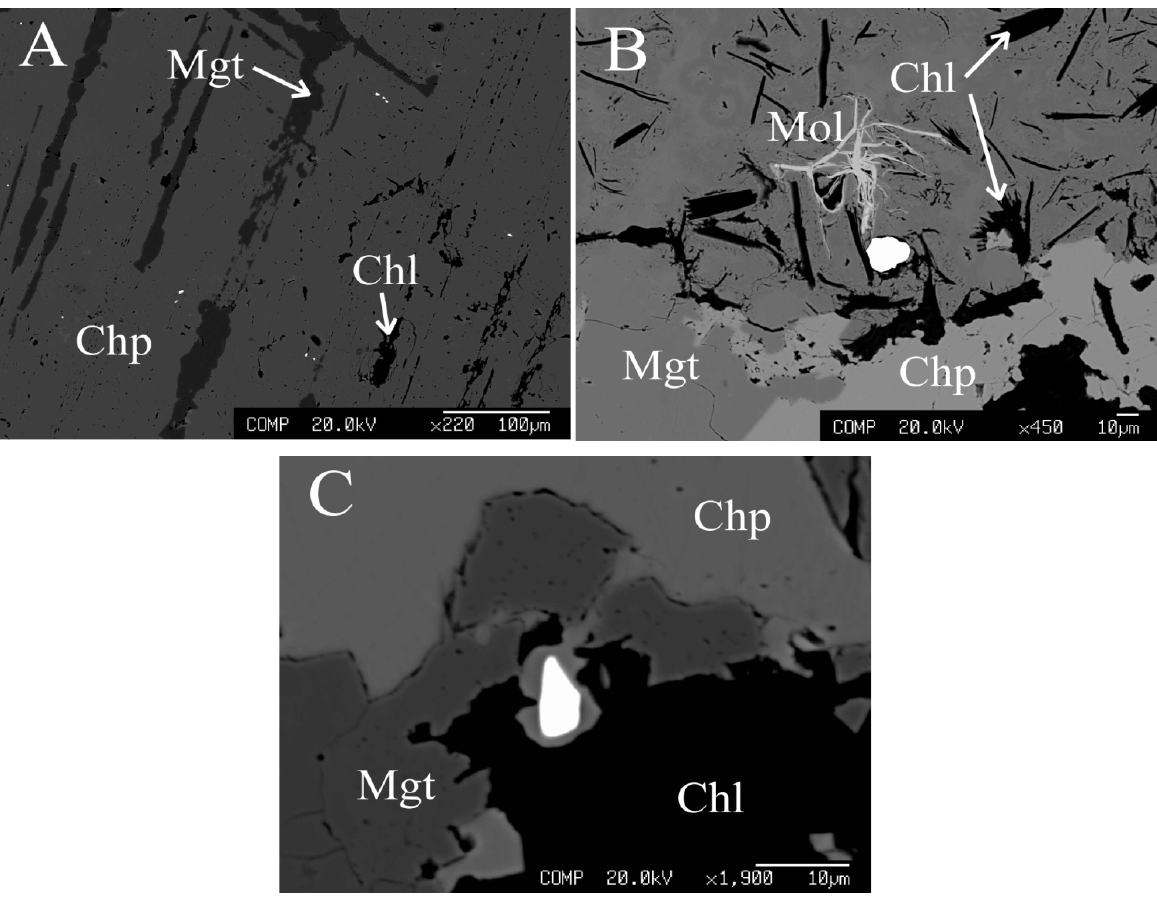
Figure 6. Backscatter electron images of gold (white grains) from the Pozzo mine: ( A ) several small gold blebs included in chalcopyrite; ( B ) gold associated with molybdenite; and ( C ) gold rimmed by magnetite. Abbreviations: Mgt = magnetite, Chp = chalcopyrite, Mol = molybdenite, Chl =